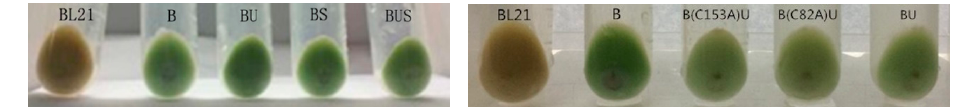
Figure 2. Color of cell pellets of transformed E. coli strains.